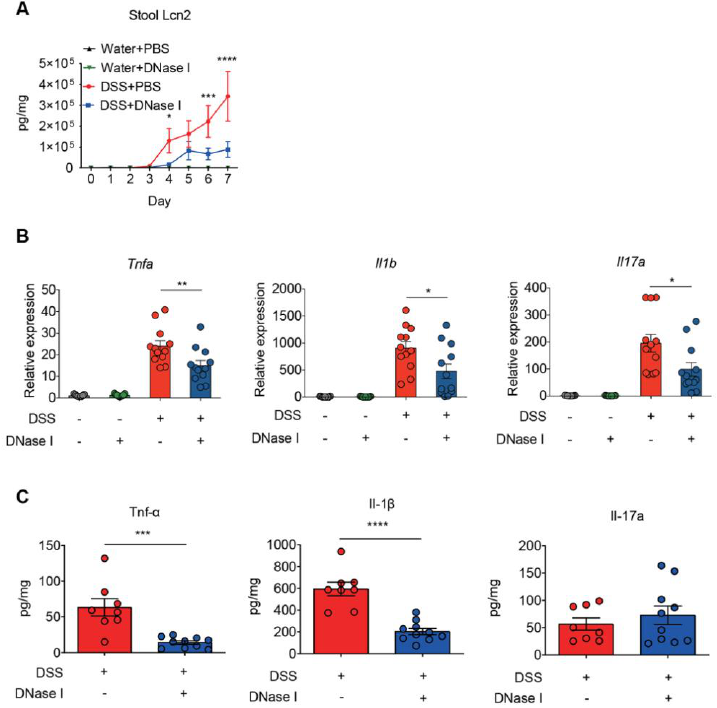
Figure 4. Disruption of NETs reduces the colonic inflammation in mouse fed DSS-containing water. ( A ) Fecal lipocalin-2 (Lcn2) levels. Fecal samples obtained from PBS- or DNase I-administered wild-type C57BL/6 mice 8 d after the consumption of clean water or 2.5% DSS were analyzed at different